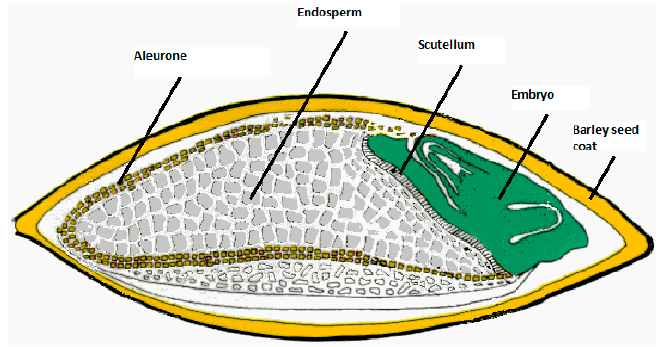
Figure 1. Barley structure.